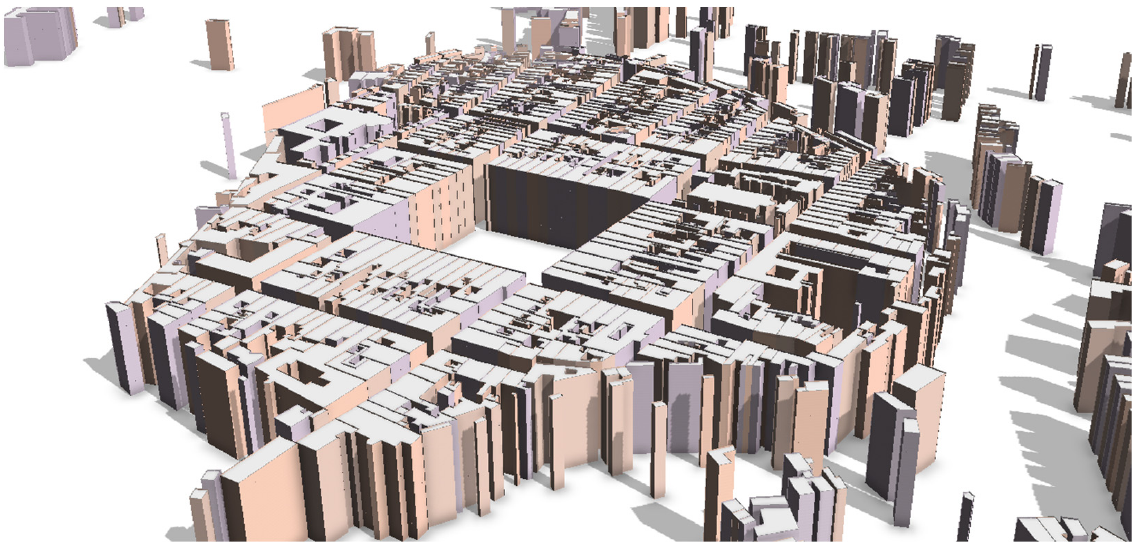
Figure 7. Procedurally modelled foundations for buildings.